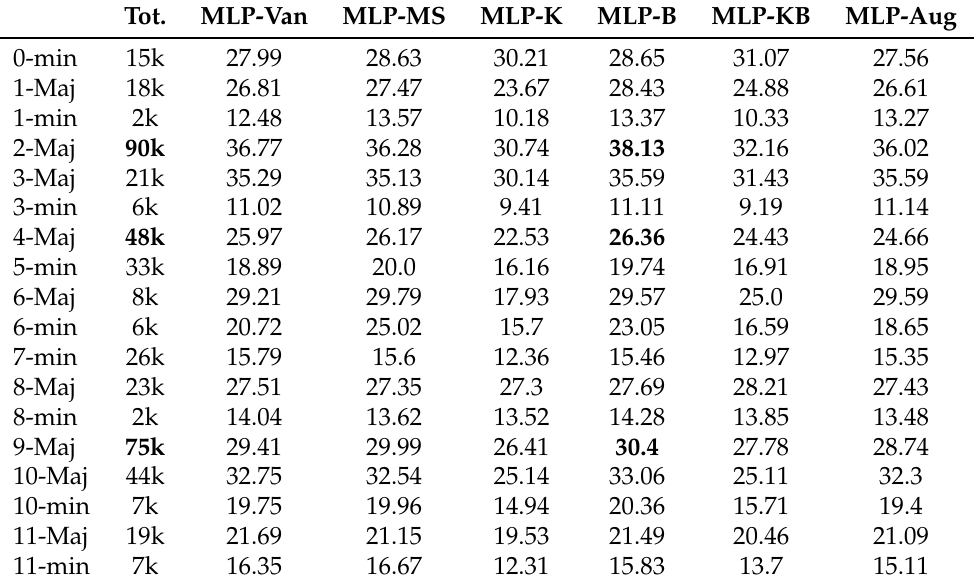
Table 12. For each class of non-diatonic chord (relative scale starting from the tonic of the key): total amount of instances in the corpus (Tot.) and percentage of correct predictions for each of the models.